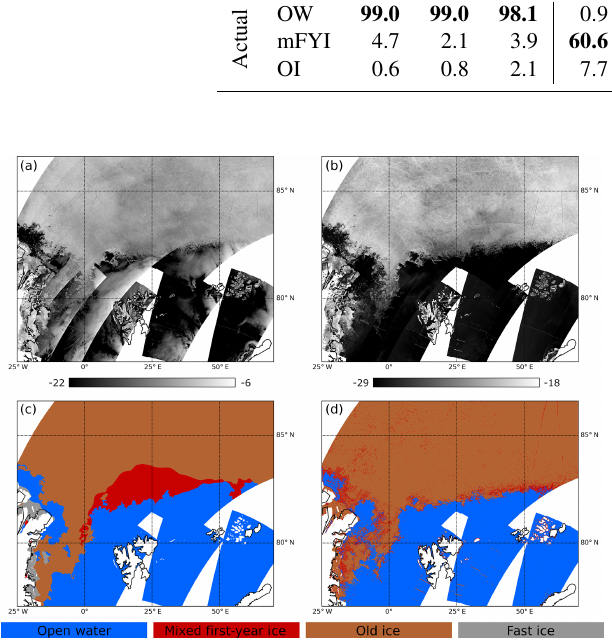
Table 8. Confusion matrix of the three-class RF classifier which was trained with the DS1 summer dataset and applied to the DS1 summer dataset of each month. The bold font indicates where the classification was done correctly. Predicted (FC1) OW (open water) mFYI (mixed first-year ice)